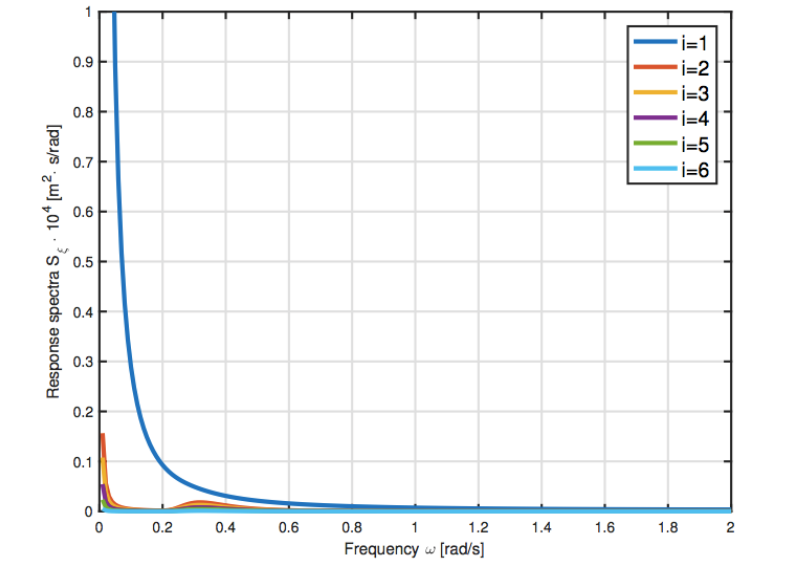
Figure 13. Response spectra for the displacement in physical coordinates of the offshore wind turbine